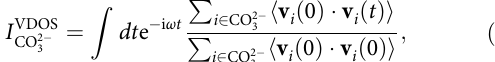
species. The VDOS of 3